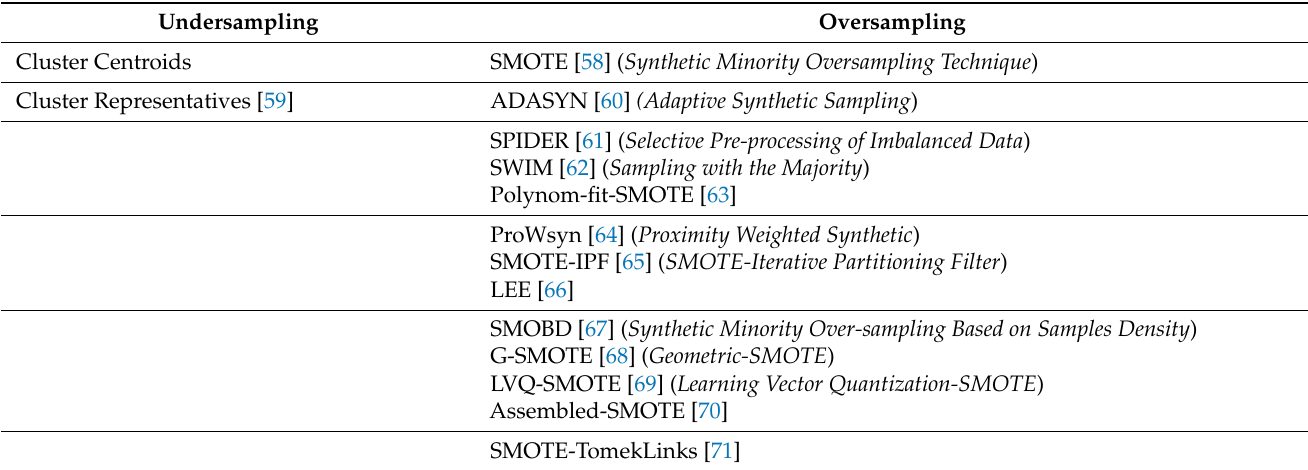
Table 3. Different resampling methods to correct the imbalance between classes.